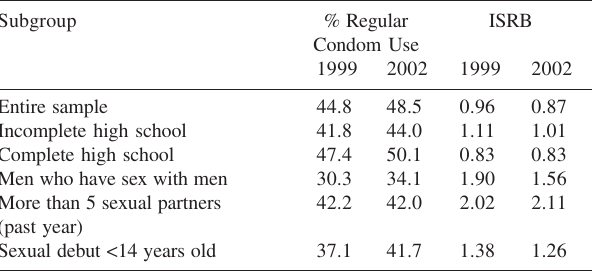
Table 4 - Indicators (%) of sexual behavior in